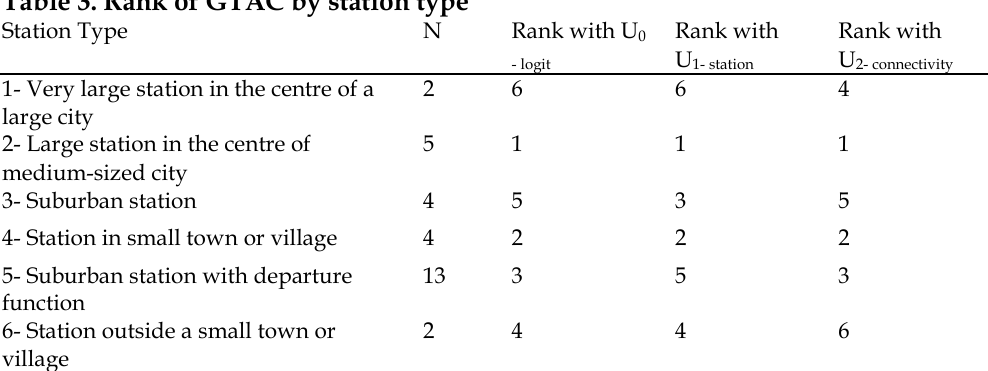
Table 3. Rank of GTAC by station